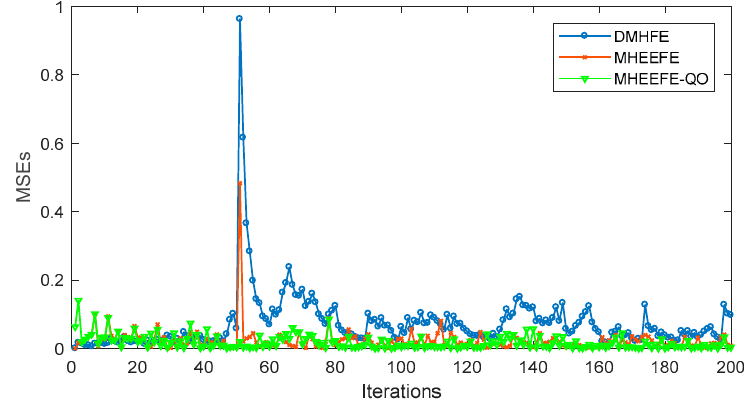
Figure 9. MSEs with the drastically changed components.